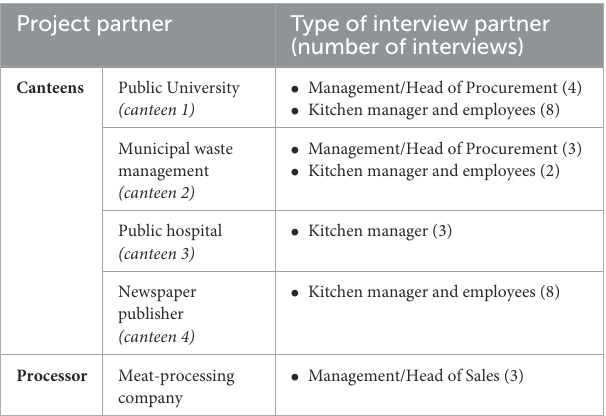
TABLE 2 Interviews carried out from April 2020 to November